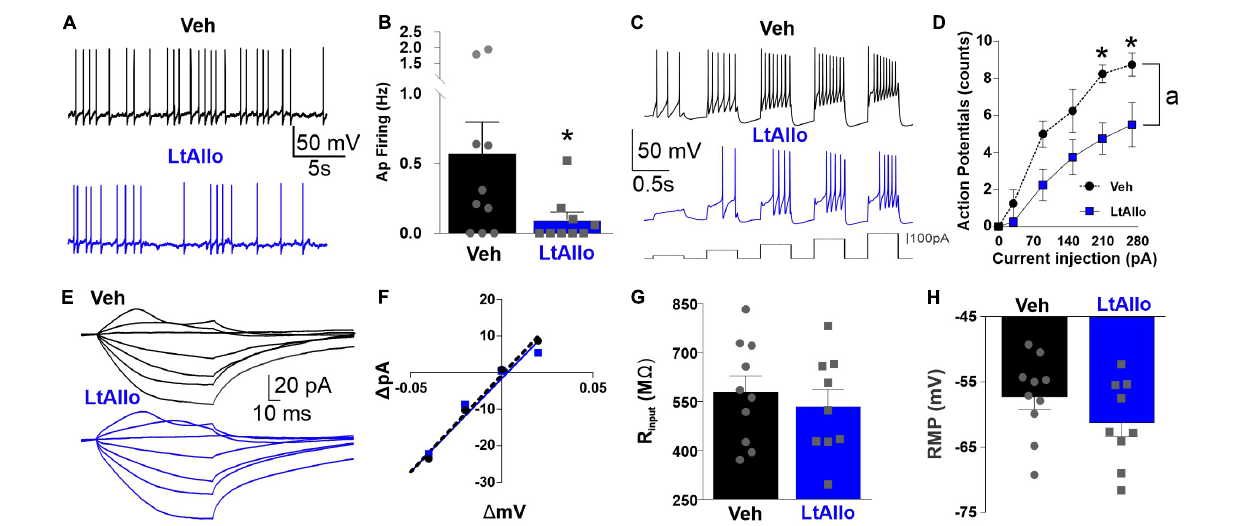
FIGURE 6 | Neuronal excitability of DMV is decreased during LtAllo. (A) Representative traces of action potential (AP) firing from Veh- (black trace) and LtAllo-treated (blue trace). (B) Mean ± SEM of spontaneous AP firing in Veh- (0.6 ± 0.2 Hz; n = 9 from 5 mice) and LtAllo-treated (0.1 ± 0.06 Hz; n = 9 from 5 mice) neurons. Unpaired Student’s t -test. (C) Representative traces showing the response of DMV neurons to step-injections of direct depolarizing current (60 pA-step, 400 ms long) from 30 to 270 pA during Veh- (black trace) and LtAllo-treatment (blue trace). (D) Mean ± SEM AP-response curves from Veh-treated (range: 0–8.8 AP; n = 4 from 2 mice) and LtAllo-treated (range: 0–5.5 AP; n = 4 from 2 mice) DMV neurons during LtAllo. Holding potential, − 60 mV. Unpaired Student’s t -test. (E) Representative traces of membrane response from DMV neurons from Veh- and LtAllo-treated groups to stepped current injections. (F) The current-voltage (I–V) relationship graph from representative Veh- and LtAllo-treated DMV neurons. (G) Mean ± SEM of IR in Veh- (579.1 ± 55.0 M (cid:127) ; n = 9 from 5 mice) and LtAllo-treated (535.6 ± 51.3 M (cid:127) ; n = 9 from 5 mice). Unpaired Student’s t -test. (H) Mean ± SEM of resting membrane potential (RMP) in Veh-treated ( − 55.9 ± 1.6 mV; n = 9 from 5 mice) and LtAllo-treated (61.2 ± 2.2 mV; n = 9 from 5 mice) neurons. Two-way repeated-measures ANOVA, interaction, p = 0.02; Sidak’s post hoc . (*) Significant difference from Veh condition. (a) Significant difference from Veh and LtAllo regardless of current injection. Significance indicates p ≤